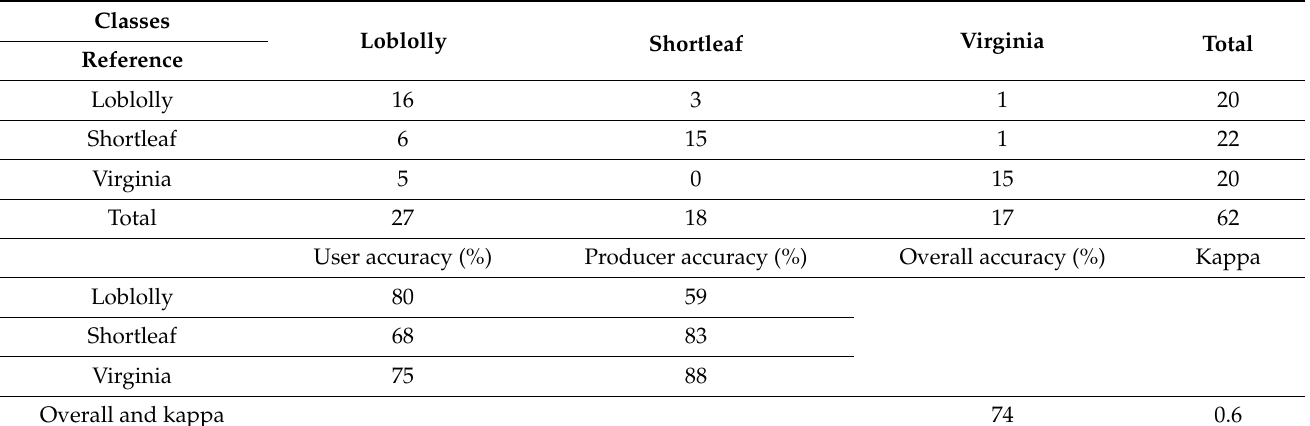
Table 2. Error matrix table for southern yellow pines’ classification of February